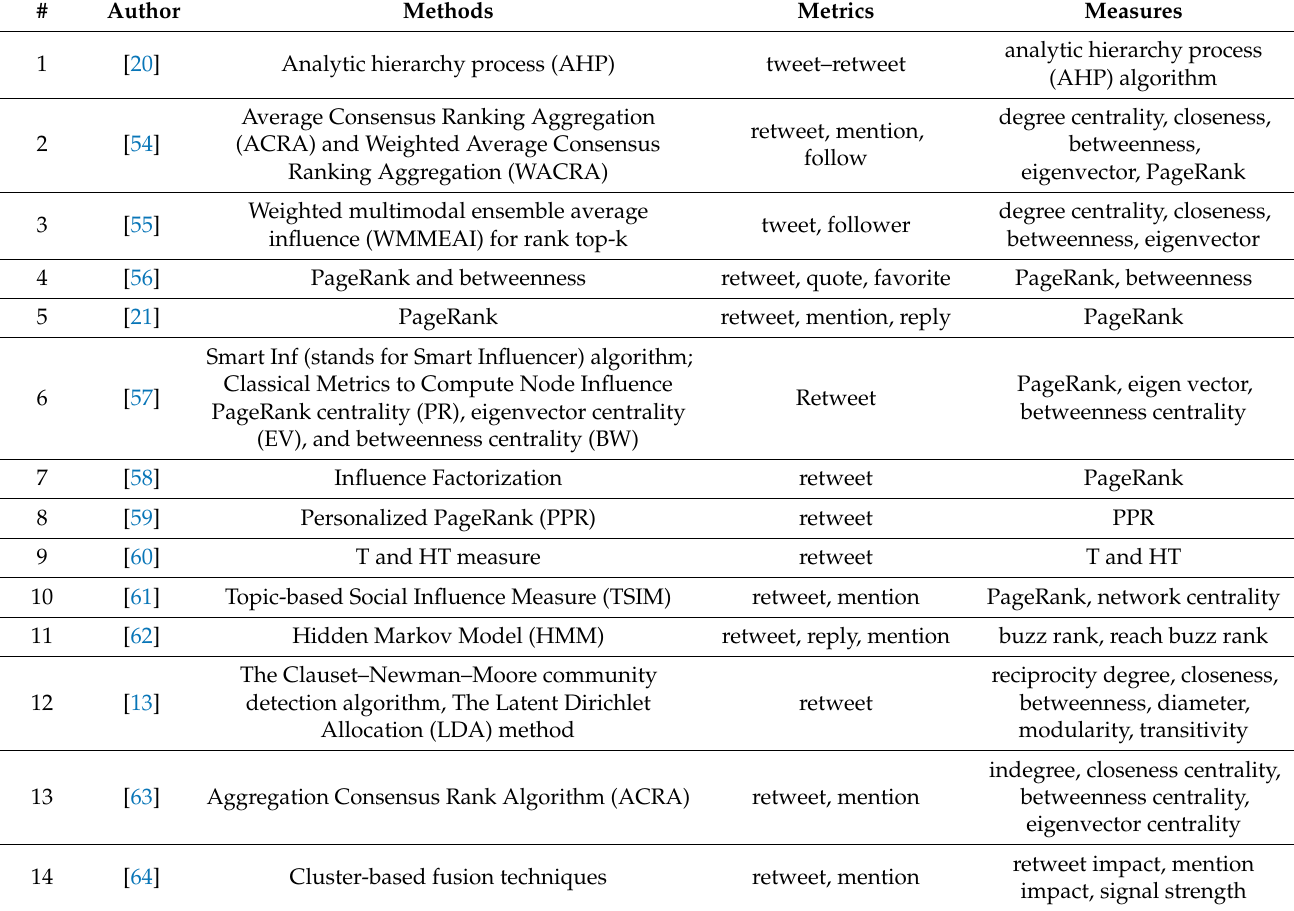
Table 5. Studies of influential users on Twitter.